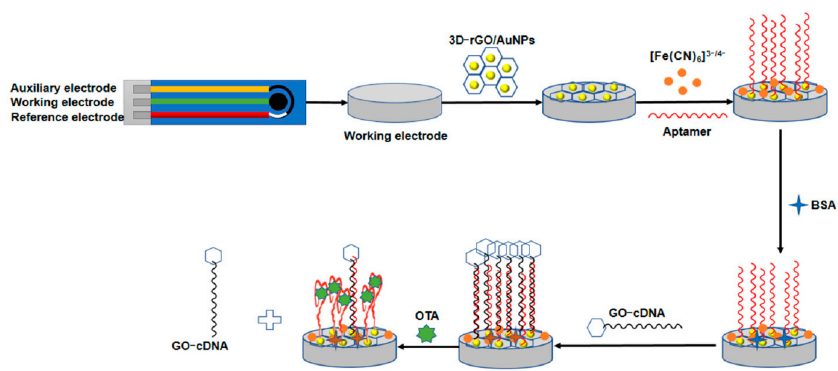
Figure 19. Working principle of competitive aptasensor labelled with graphene oxide-complementary DNA conjugates (GO-cDNA) for the electrochemical detection of ochratoxin A. Adapted with permission from Hu et al. [76] (under the terms and conditions of the Creative Commons CC BY License 4.0).